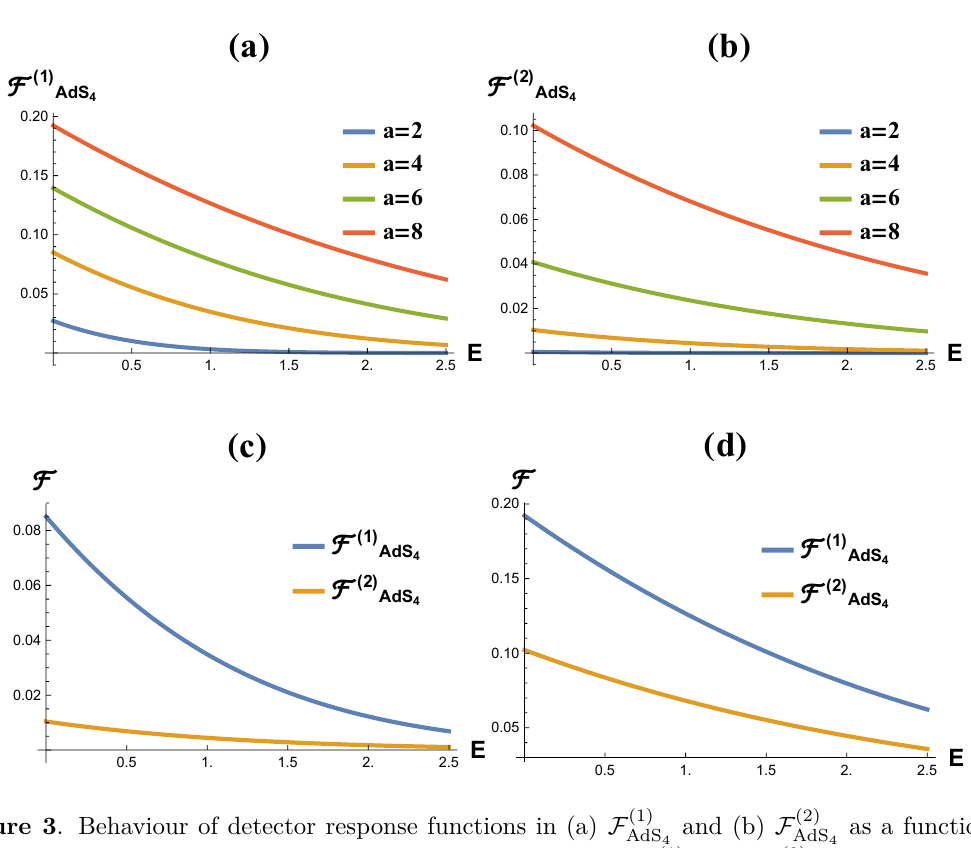
Figure 3 . Behaviour of detector response functions in (a) F (1) energy E for different values of acceleration a . Comparison of F (1)